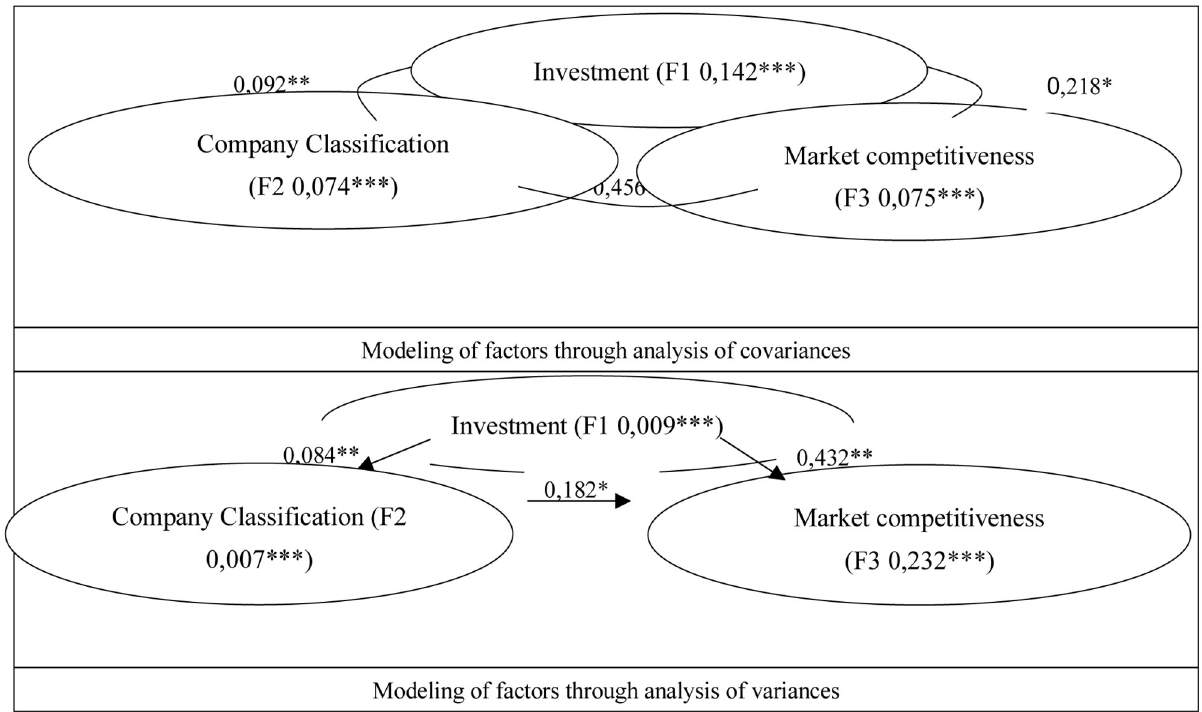
Fig 1. Structural modeling of covariance and variance. Source: The researcher. Research project: Government support for companies in Talca, Chile, in times of Covid-19.